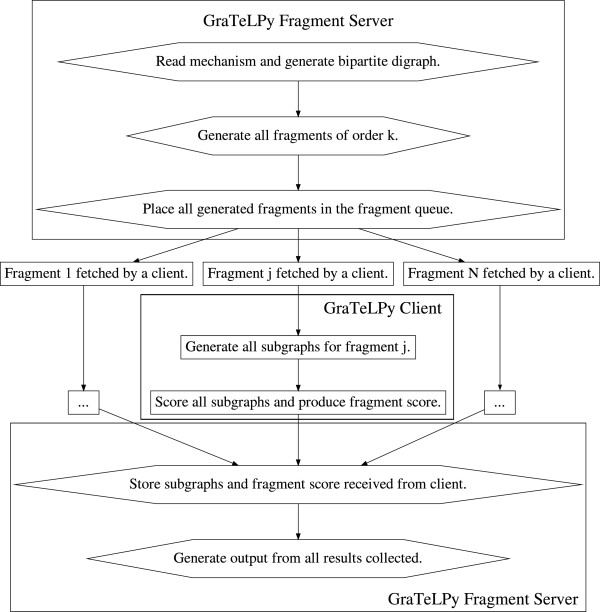
Flowchart that summarizes the steps taken by GraTeLPy to find all critical fragments of a given order. The division of tasks between a single server and one or more clients is highlighted. (top diamonds) The fragment server reads in the user-specified mechanism file and generates the bipartite digraph. The server generates all fragments of an user-defined order k and places them in a queue. (center rectangles) One or more client scripts fetch fragments off the queue and process them independently. For each fragment Sk, a client generates all subgraphs and computes the weight of each subgraph. The subgraph weights are then added to compute the weight of the corresponding fragment. The client passes the computed data back to the server and fetches another fragment off the queue if the queue is not yet exhausted. (bottom diamonds) After preparing the fragment queue, the server waits for the results sent by the clients. Upon receipt of client-computed results for a fragment, the server stores these results if the fragment is found to have non-zero weight. Once the queue is exhausted, the server informs the user about the number of critical fragments discovered and generates other informative output.